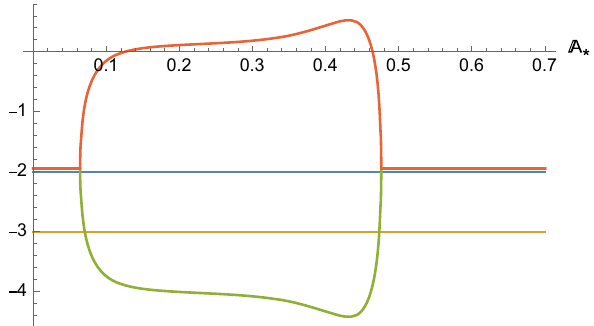
Fig. 5 Plot of the real part of the eigenvalues of the fixed points of the line L for Model 3. Here α has been chosen to be 3 and w = 0. Its increase wides the set of values of A ∗ for which two of the eigenvalues have discordant sign as in the case of Model 2, the solution associated to this fixed point is